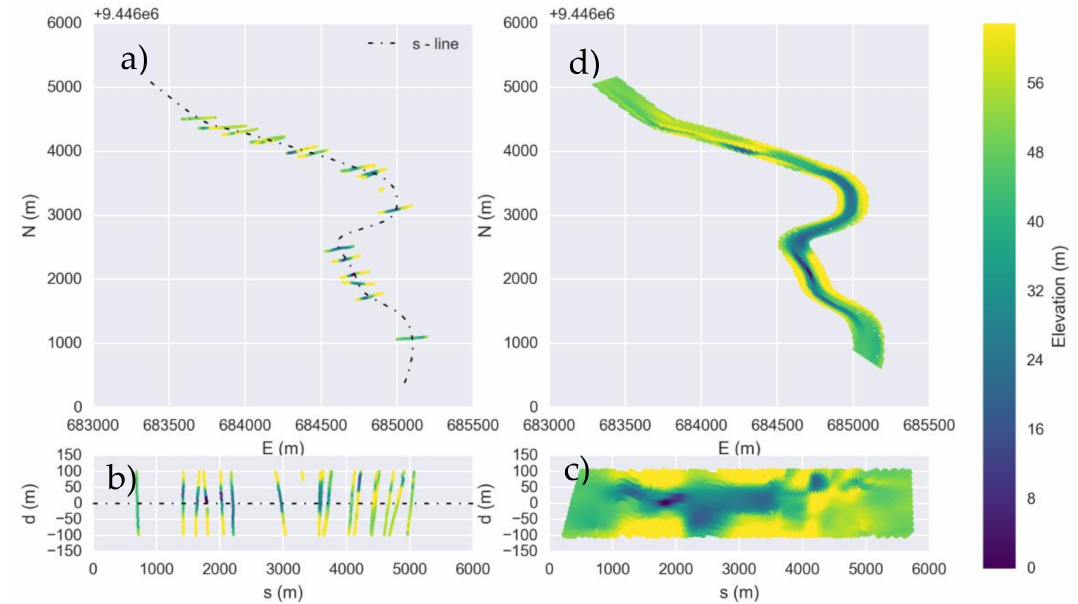
Figure A1. ( a ) Bathymetry data (below 63 m) in a regular coordinate system grid (E-N); ( b ) Bathymetry data transformed in the s-d grid (by s-line direction); ( c ) Kriging interpolation using the s-d grid; ( d ) Interpolated bathymetry grid along the canyon central path in a regular